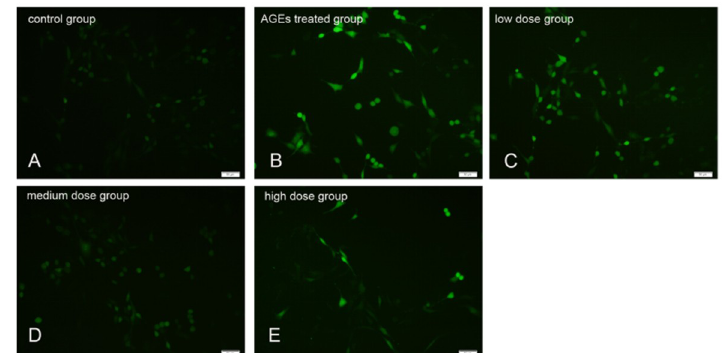
Figure 3. KM treatment reduces the production of ROS in AGE-treated GMCs. Detection of intracellular ROS using DCFH-DA in ( A ) control group cells, ( B ) cells treated with AGEs (160 μg/mL) for 24 h, and ( C – E ) cells pre-treated with 10, 20, or 35 μM KM and then stimulated with AGEs (160 μg/mL) for 24 h. The photographs were taken directly from culture plates with an inverted fluorescence microscope (magnification 50 × ).